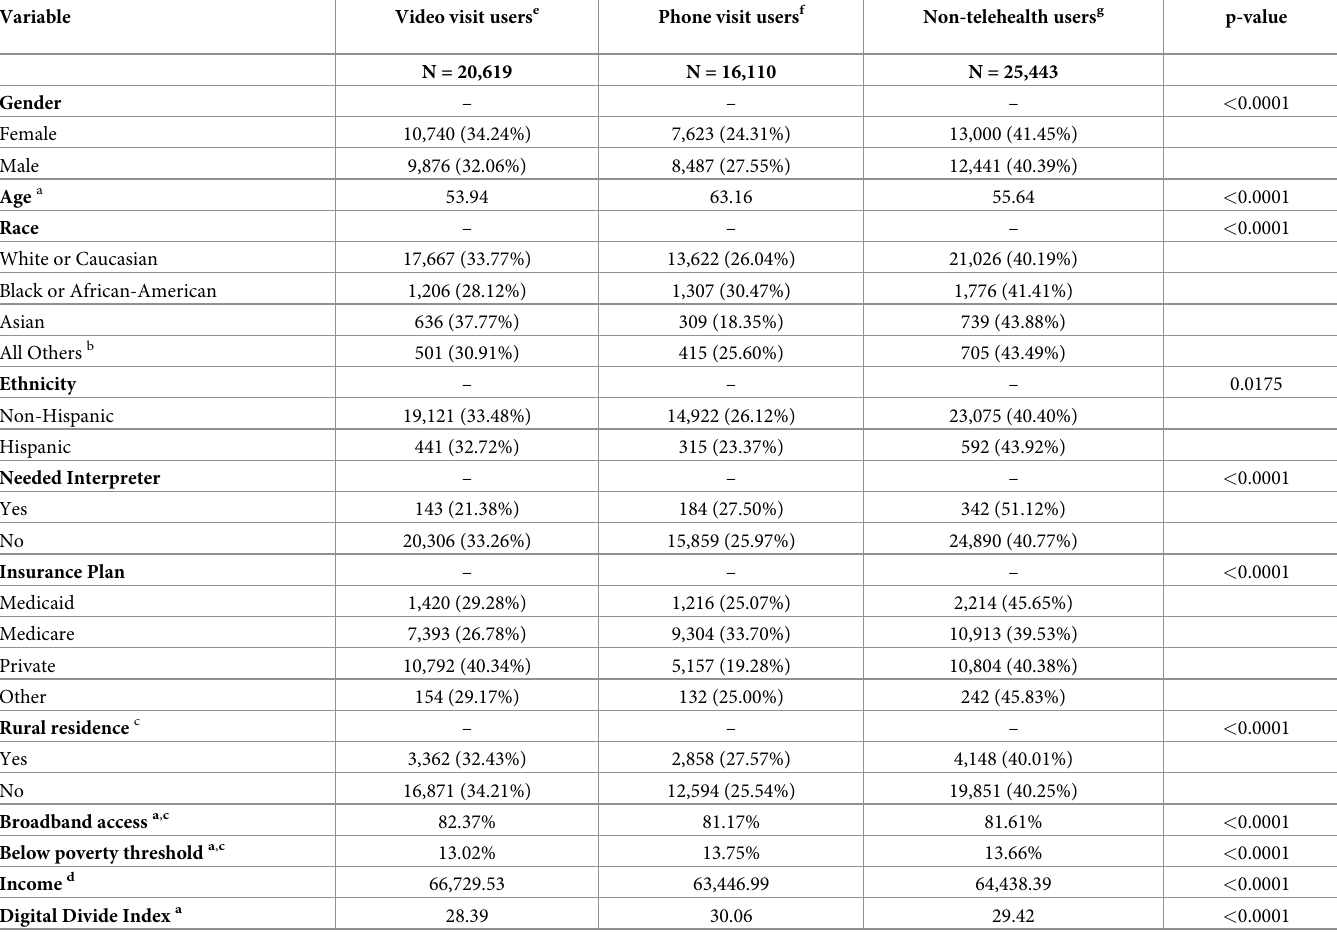
Table 2. Characteristics of patients seen in any oncology specialty (N = 62,172) during the COVID-19 pandemic (Phase 1 and Phase 2) using each visit